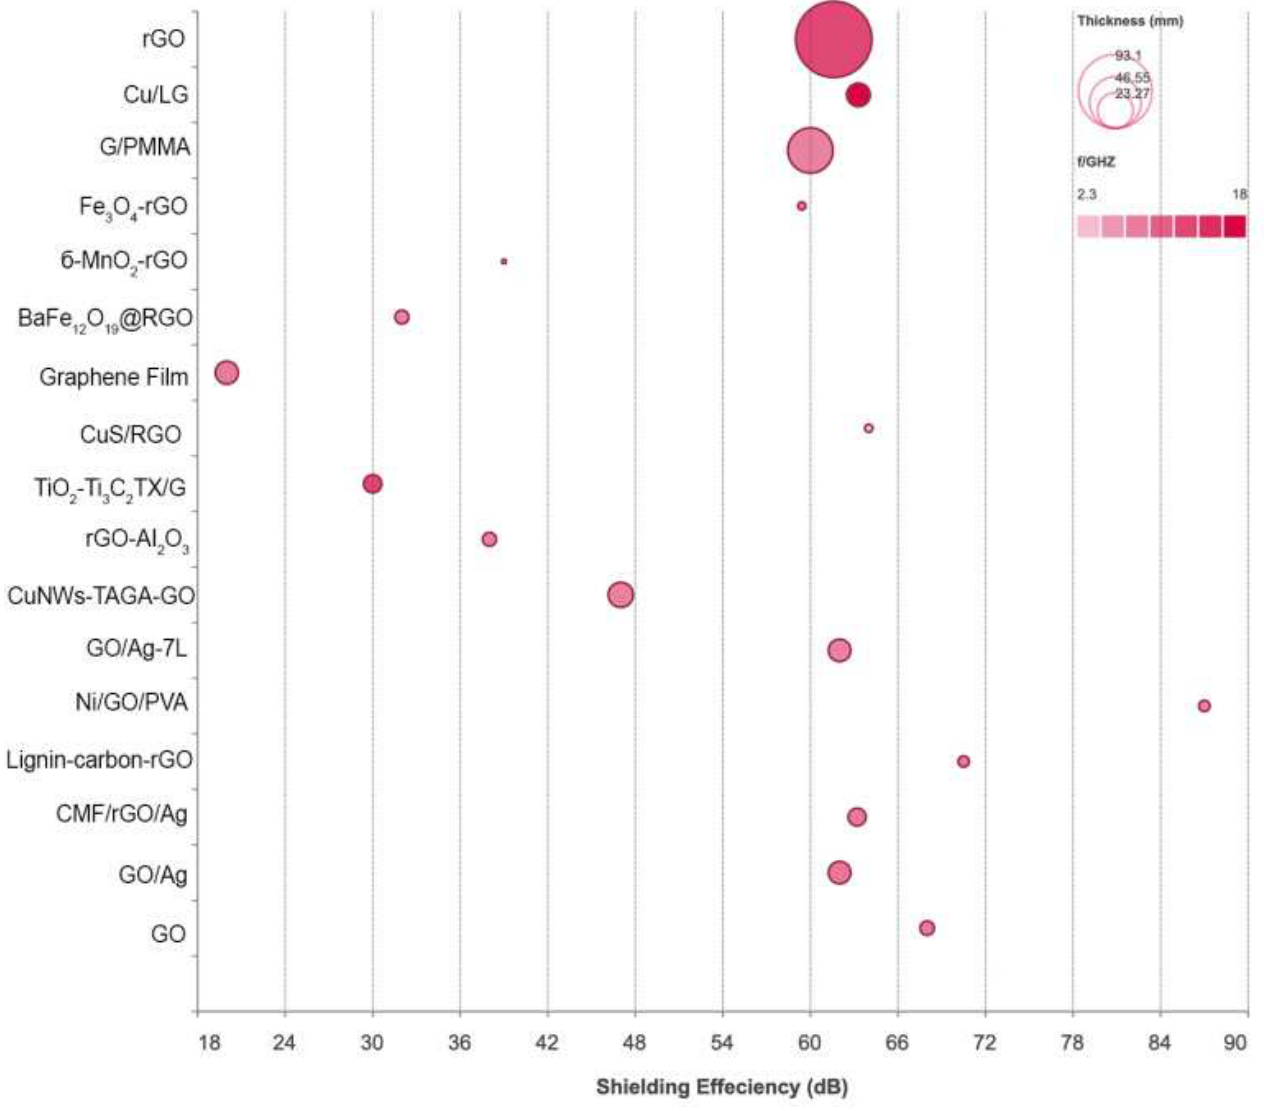
Figure 6. EMI shielding efficiency of GM metal hybrids. Data listed in Table 7.